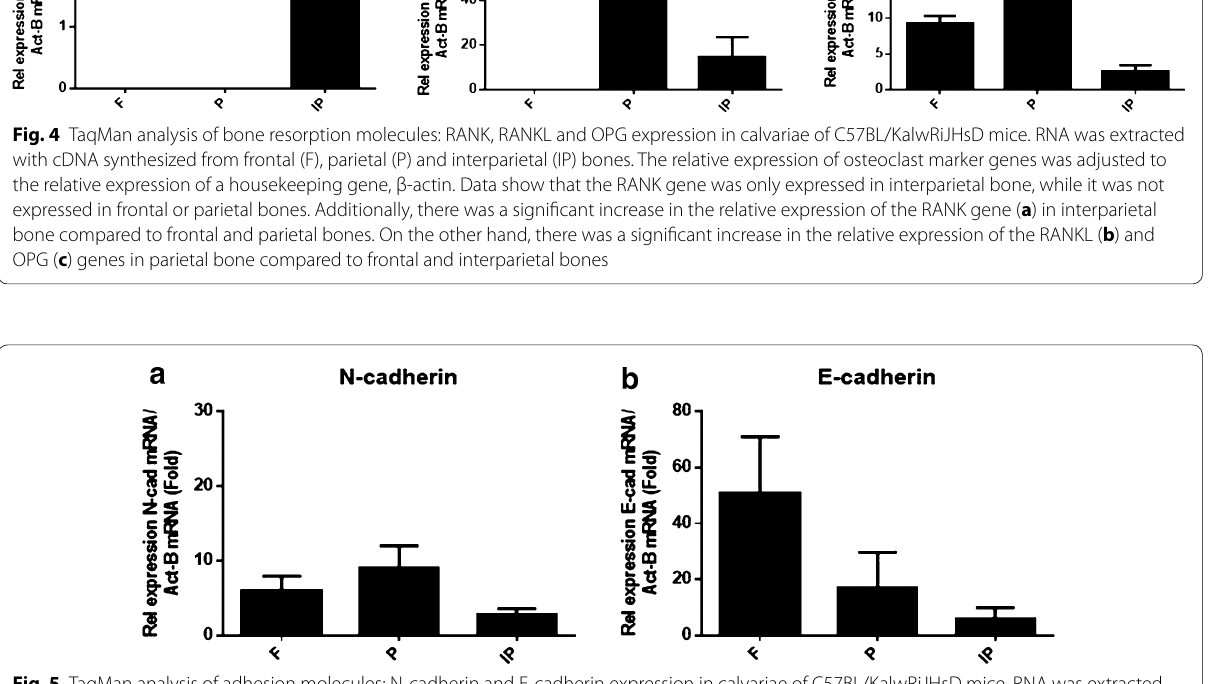
Fig. 5 TaqMan analysis of adhesion molecules: N‑cadherin and E‑cadherin expression in calvariae of C57BL/KalwRiJHsD mice. RNA was extracted with cDNA synthesized from frontal (F), parietal (P) and interparietal (IP) bones. The relative expression of adhesion molecule was adjusted to the relative expression of a housekeeping gene, β‑actin. There were no differences in the relative expression of N‑cadherin ( a ) and E‑cadherin ( b ) between frontal, parietal and interparietal